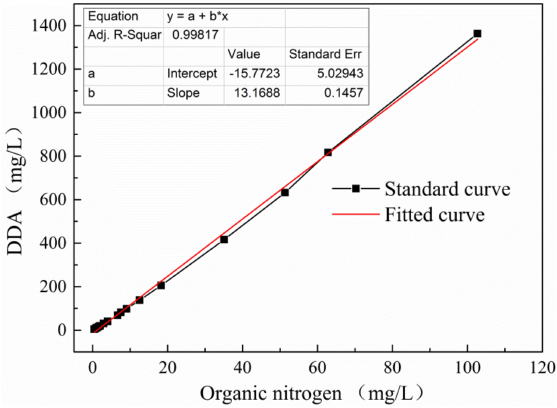
Figure 1. Standard curve of dodecyl amine (DDA)-N content obtained through total organic nitrogen (TON)